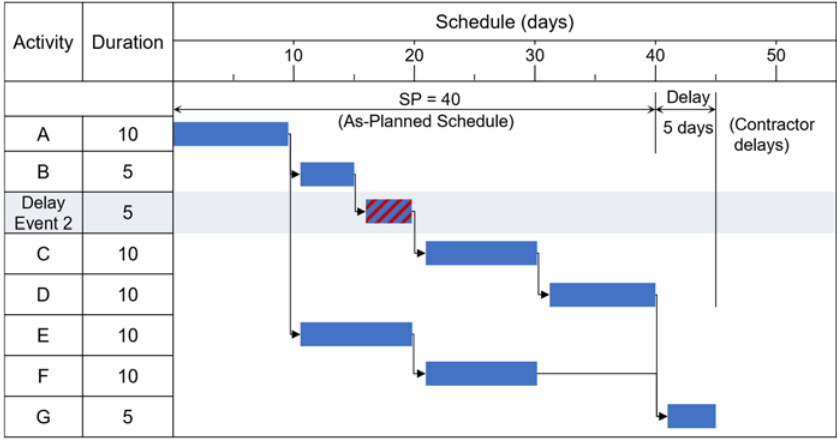
Figure 13. Contractor ‐ caused delay.